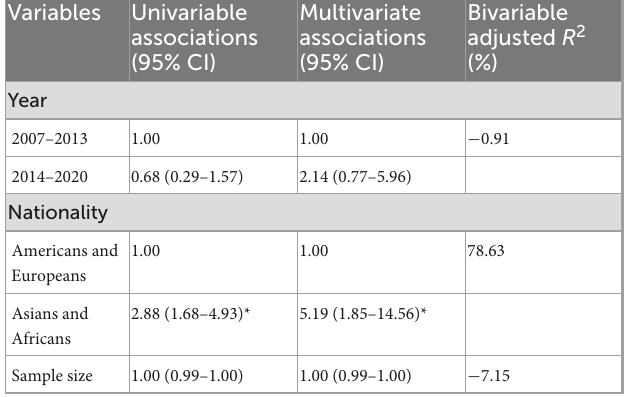
TABLE 3 Result of random effect meta-regression on the association between current smoking and binge drinking in both